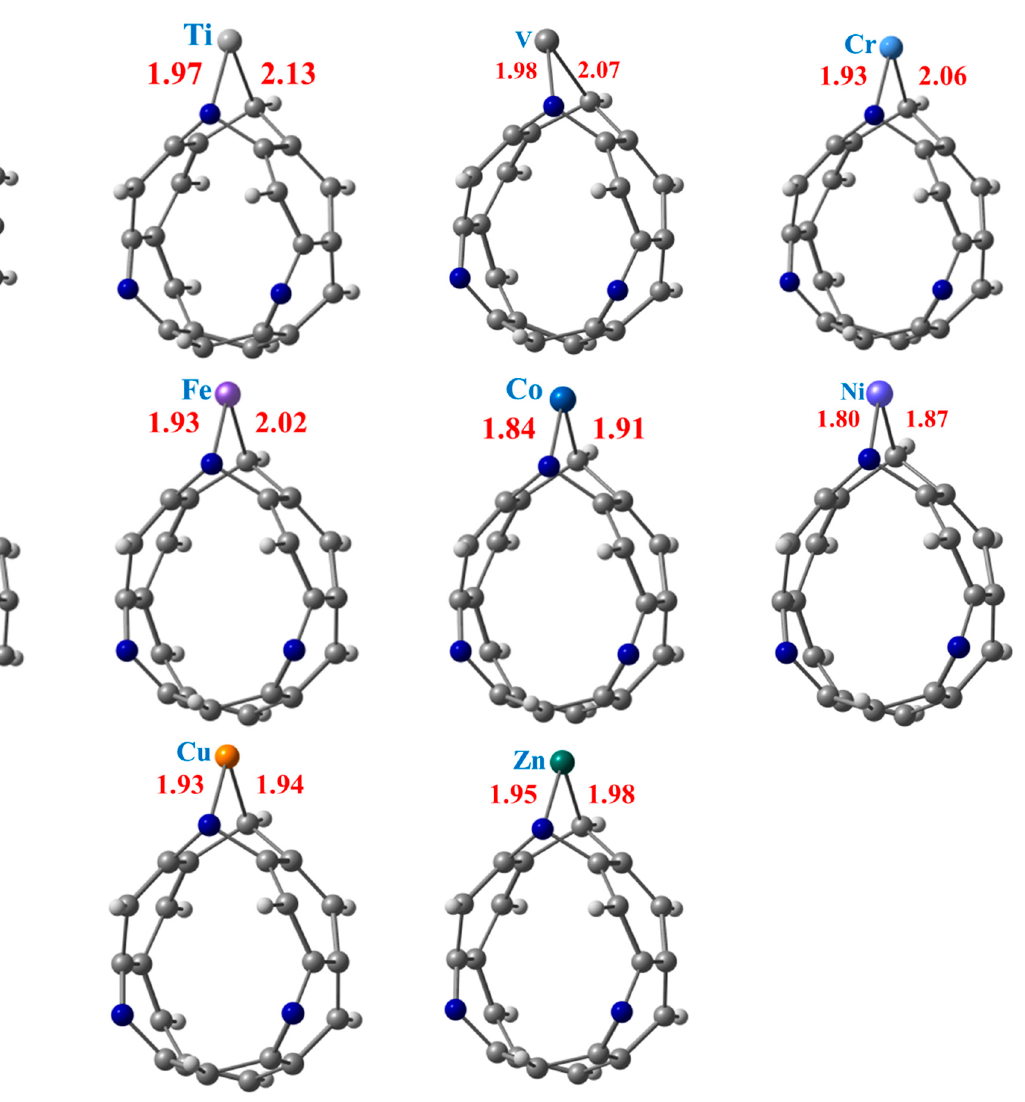
Figure 2. Optimized structures of stable TM@NB complexes (TM = Sc-Zn) at ω B97XD/6-311G(d,p) level of theory. Where grey, whitish, and blue balls represent carbon, hydrogen, and nitrogen atoms, respectively. Table 1. Summary of energies for the interaction of TM atom over nanobelt ( ∆ E int ), HOMO (eV), LUMO (eV), energy gap (eV), and NBO charges on TM atom of all considered TM@NB complexes. Complexes Δ E int (eV)